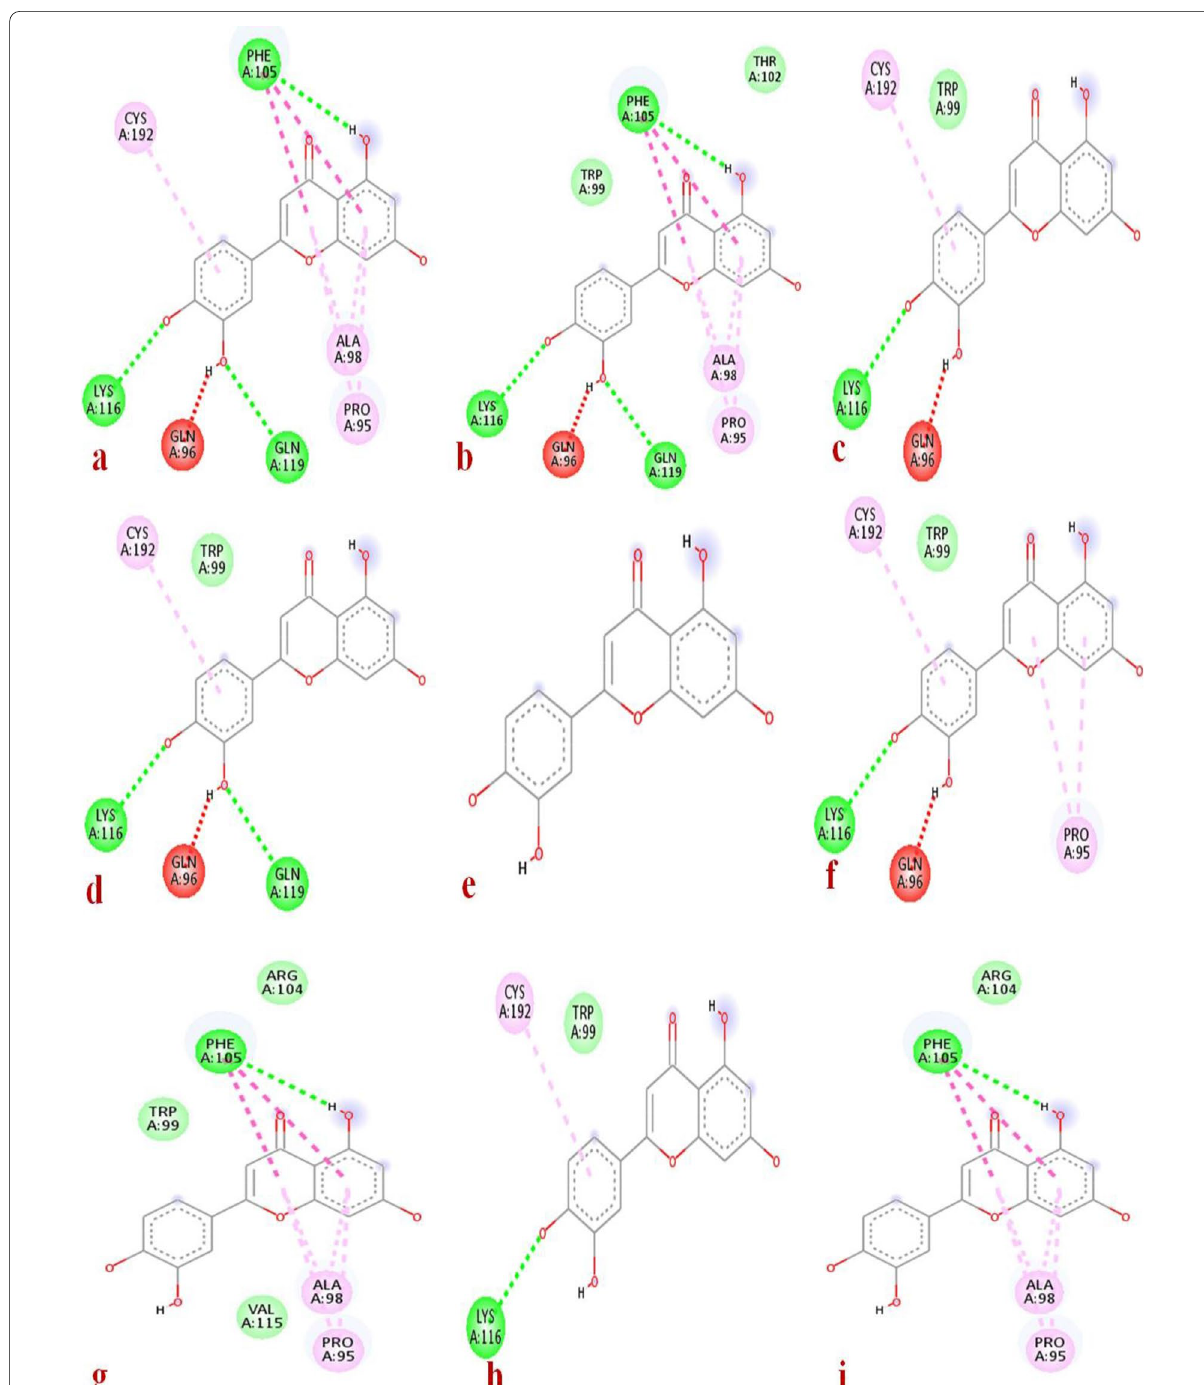
Fig. 4 Interaction representation of V2R with luteolin. H-bonding Van der Walls Interaction Pi-Cation Pi-Pi Stacked Alkali Pi-Sulphur . Conventional H-bonding with bond distance PHE105, GLN-119,